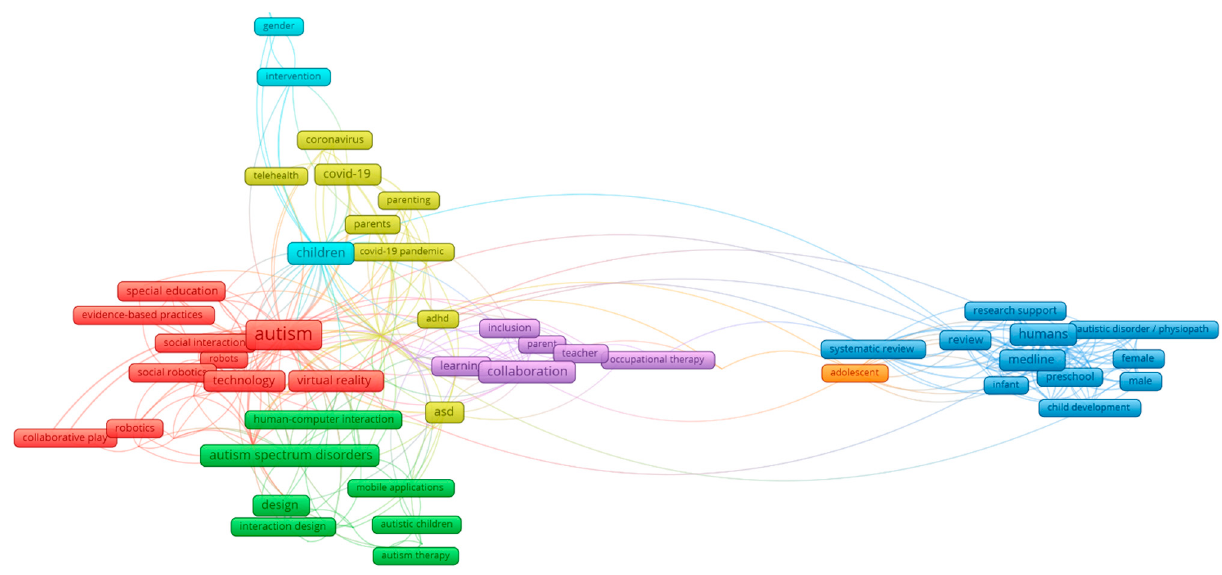
Figure 4. Keyword analysis for the bibliographic study.